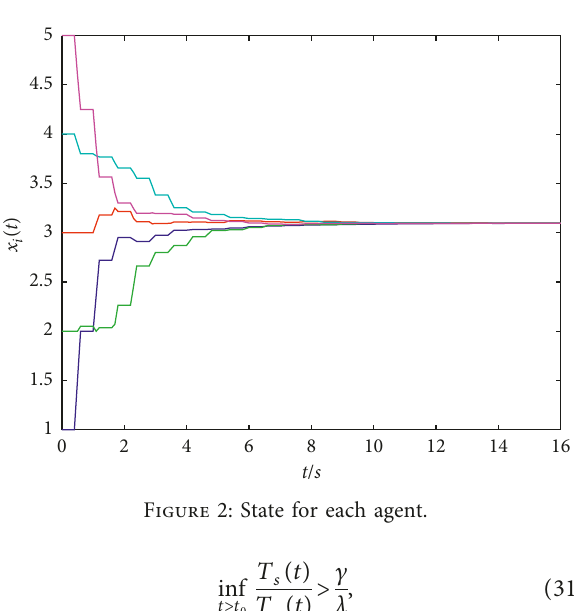
Figure 1: Switching topologies: G (c) G 3 , (d) G 4 , and (e) G 5 .